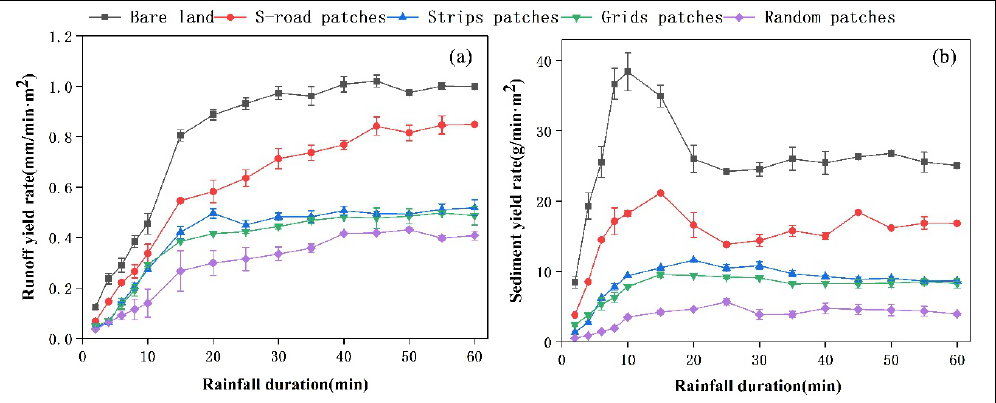
Figure 4. Variation in rates of runoff ( a ) and sediment transport ( b ) under different types of vegetation patches.